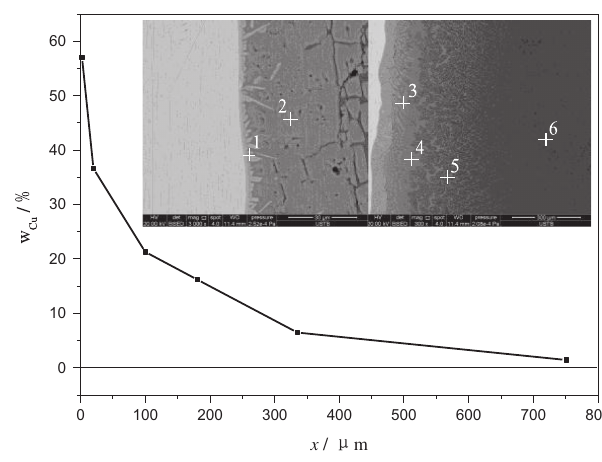
Figure 9: EDS analysis of Cu element in the transition